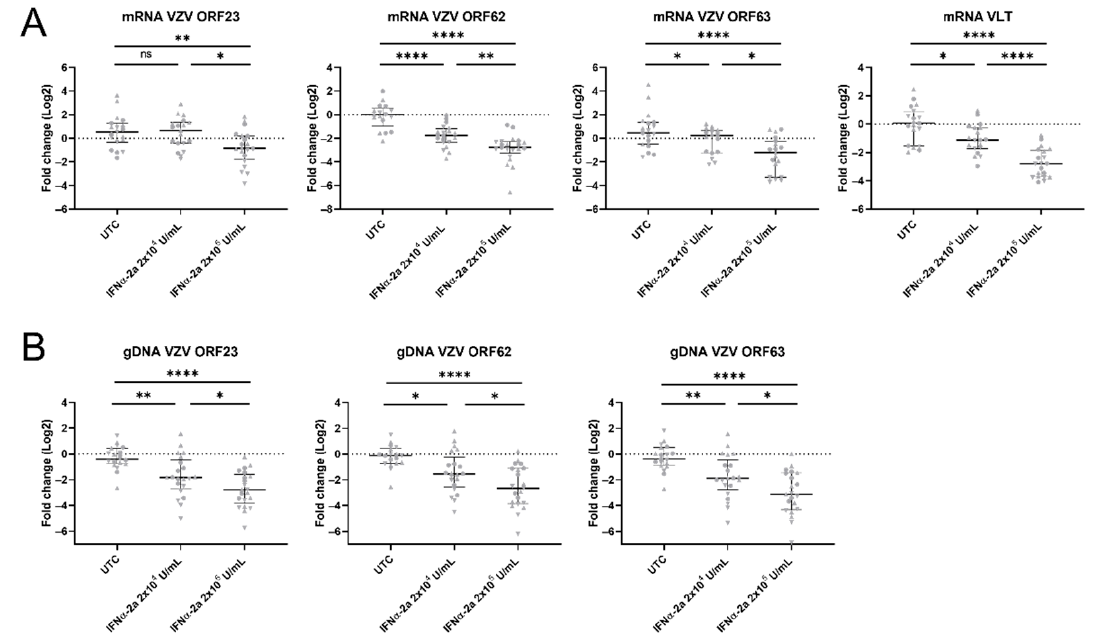
Figure 7. IFN α reduces VZV transcript expression and VZV genome replication. ( A ) Relative quan- tification of mRNA transcripts in the cell body compartment at 7 dpi by RTqPCR. Transcript expres- sion (log2) was set out relative to the mean of the untreated control group (UTC), i.e., fold change. Each symbol represents the log2 fold change of a single culture originating from one of three inde- pendent biological repeats (Experiment 1: circles, ORF23 n = 7/7/7, ORF62 n = 7/7/7, ORF63 n = 7/7/7,